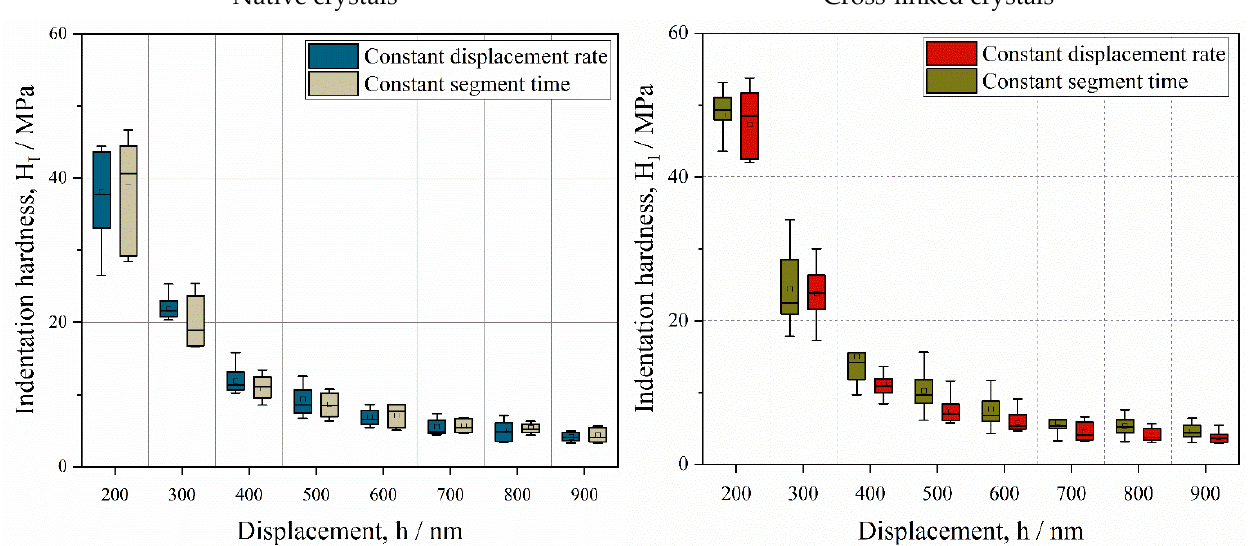
Figure 6. Indentation hardness of the prismatic faces of native ( left ) and cross-linked ( right ) crystals as a function of the depth and indentation displacement rate. The indentation rate of the constant-displacement-rate mode was 180 nm/s over the whole penetration range, while the indentation rate of the constant-segment-time mode increased from 364 nm/s at a penetration depth of 200 nm to 1636 nm/s at a penetration depth of 900 nm.